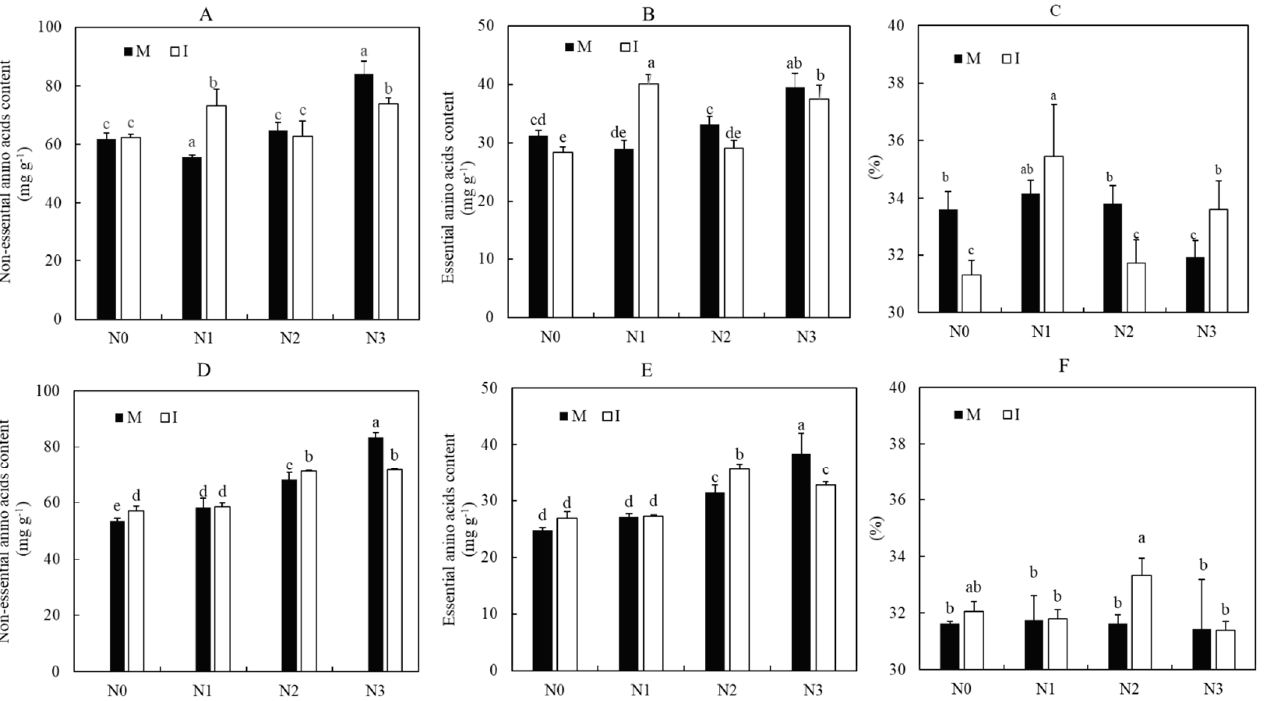
Figure 4. Essential amino acids, non − essential amino acids, and the ratio of essential amino acids to total amino acids between IW and MW under different N levels. ( A , D ) Essential amino acids in 2019 and 2020, respectively; ( B , E ) non − essential amino acids in 2019 and 2020, respectively; ( C , F ) ratio of essential amino acids to total amino acids in 2019 and 2020, respectively. MW, mono-cropped wheat; IW, intercropping wheat; different letters represent significant differences among all treatments. Each bar in the figures is the mean value ( n = 3), and error bars represent standard error.